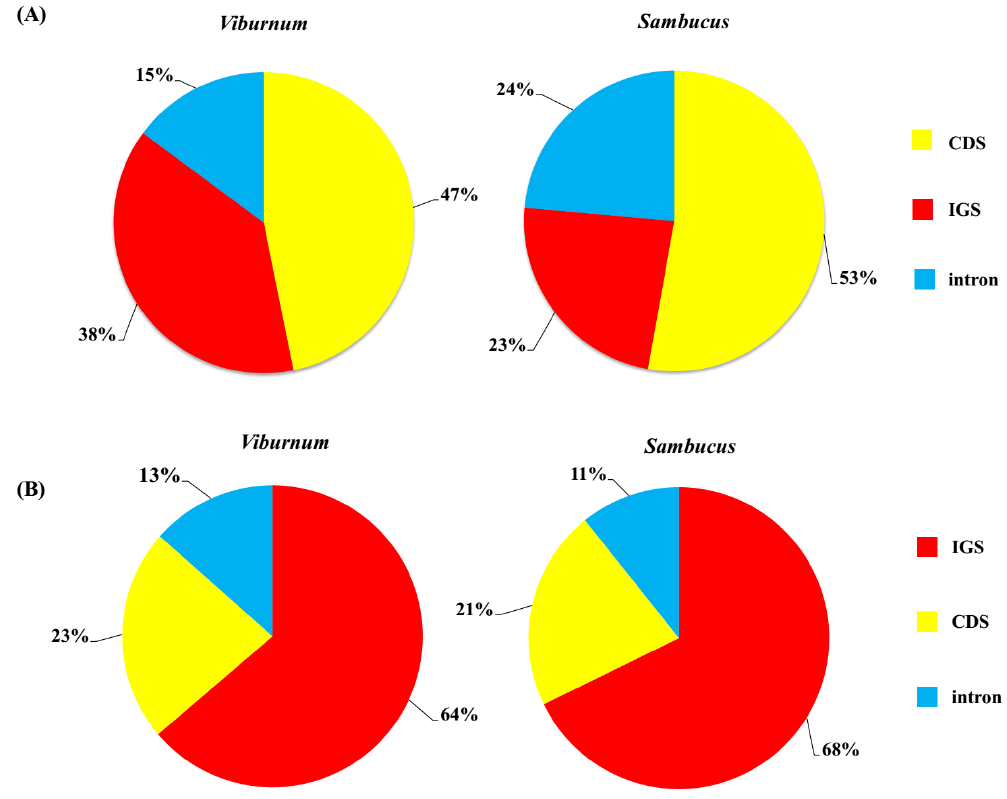
Figure A3. ( A ) The distribution frequency of repeats in chloroplast genomes. ( B ) Distribution of SSRs sites in chloroplast genomes. IGS: intergenic spacer region; CDS: protein-coding sequences.